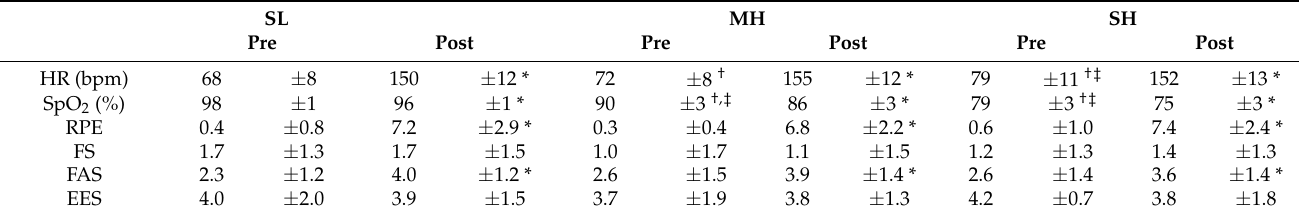
Table 1. Physiological and psychological responses to sprint interval exercise at different hypoxia.